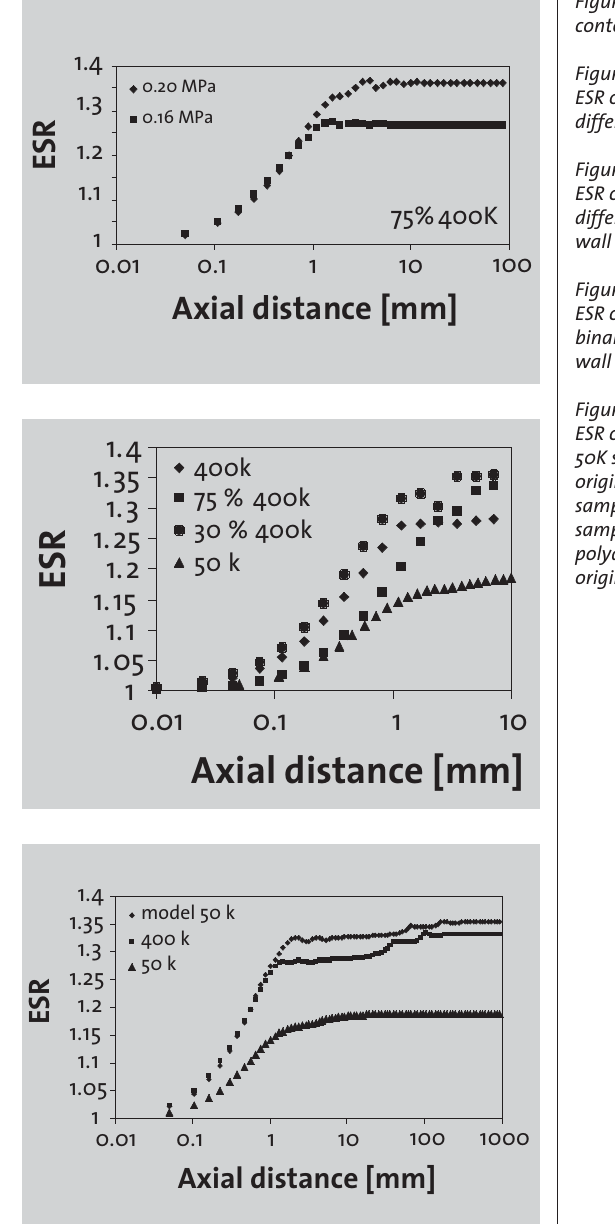
Figure 7 (left above): Stress contour around die exit. Figure 8 (right above): ESR of polymer flow at different stress level. Figure 9 (left middle): ESR comparison between different MW at constant wall stress (0.16 MPa). Figure 10 (right middle): ESR comparison between binary mixtures at constant wall stress (0.16 MPa). Figure 11 (right below): ESR comparison of artificial 50K sample with the original 400K and 50K samples. The artificial 50K sample has similar polydispersity with the original 400K